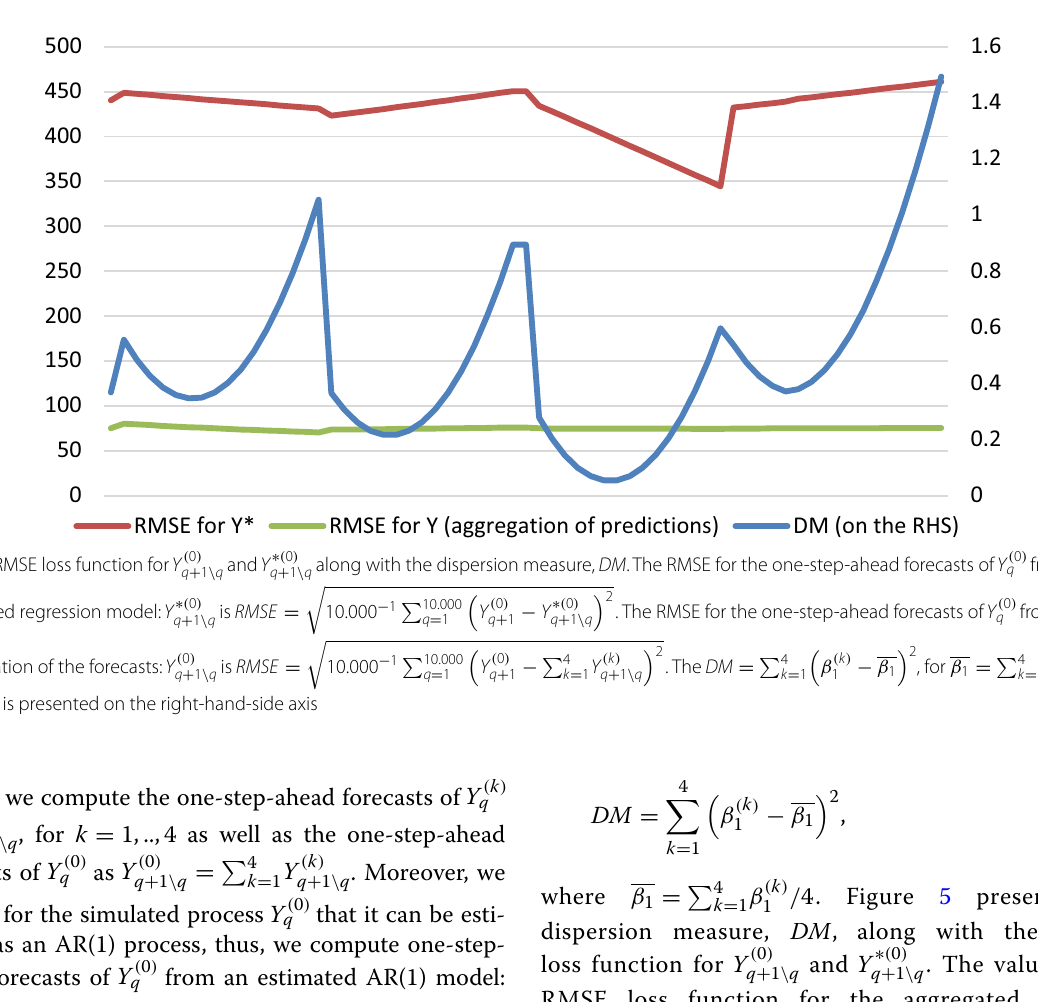
Figure 5 presents the where β 1 = dispersion measure, DM , along with the RMSE (cid:31) ( 0 ) Y ∗ ( 0 ) loss function for Y q + 1 \ q . The value of the q + 1 \ q and RMSE loss function for the aggregated forecast 4 Y ( k ) k = 1 q + 1 \ q is stable across the various values of the dispersion measure. On the other hand, the values (cid:31) of RMSE = are highly related to the values of the dispersion measure.